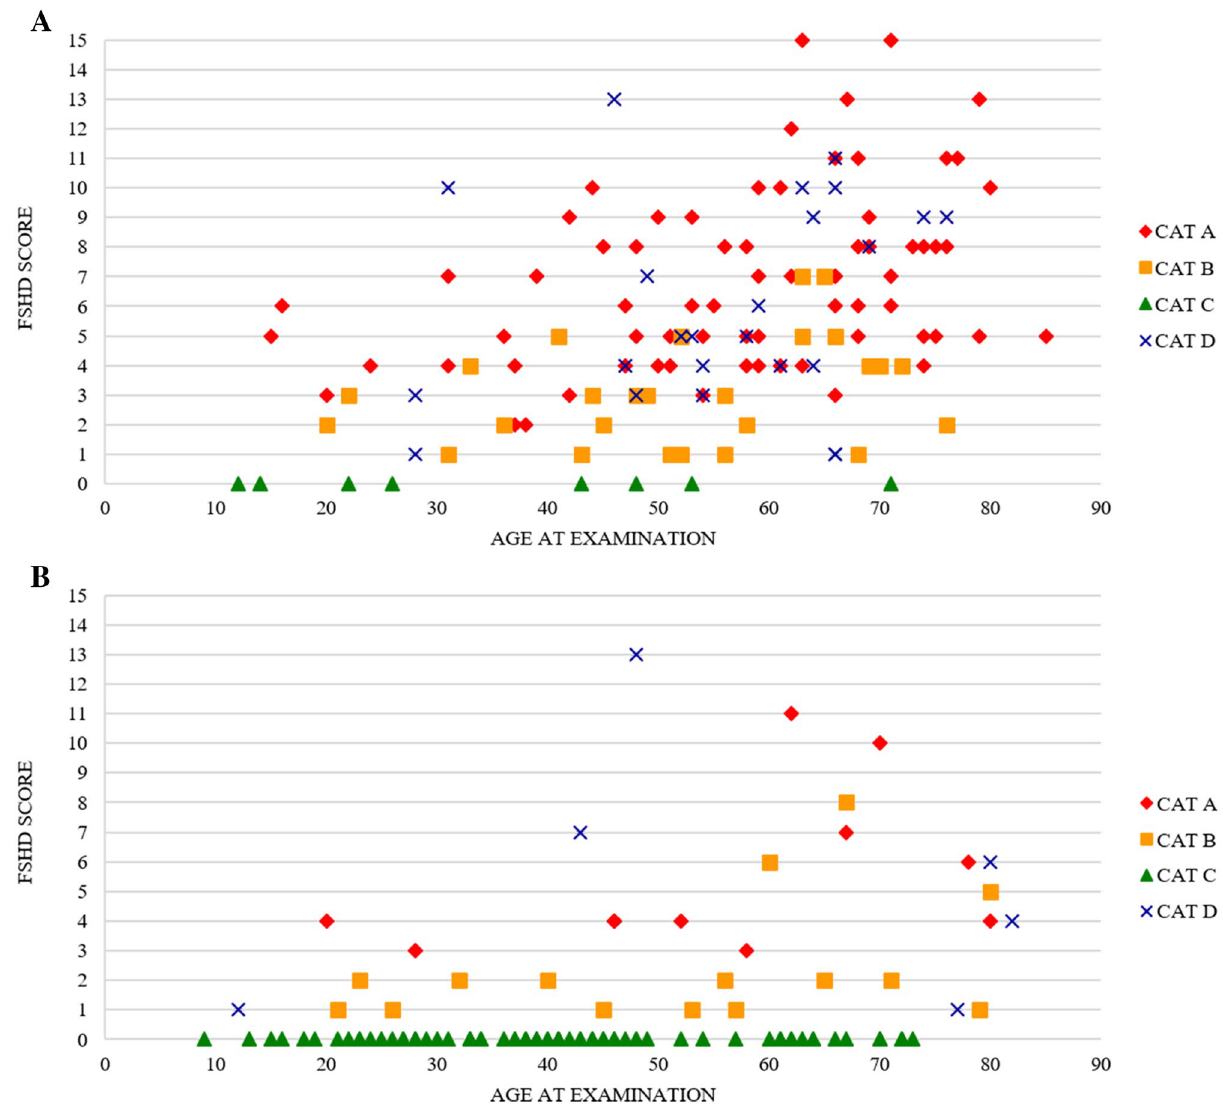
Figure 2. Distribution of clinical severity among subjects carrying a bDRA according to FSHD score and age at examination: index cases ( A ) and relatives ( B ). Clinical categories are described as follows red diamond (category A), yellow square (category B), green triangle (category C), blue cross (category D).